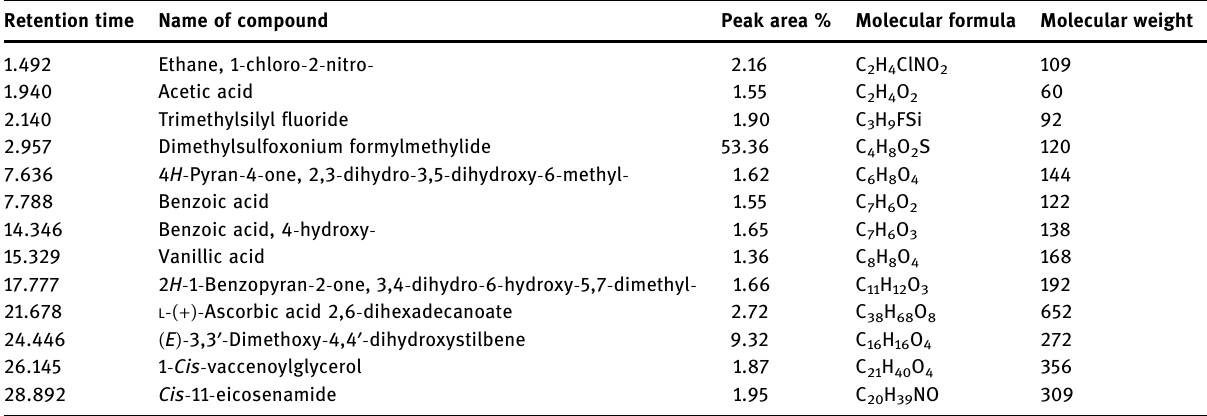
Table 5: Compounds identi fi ed in aqueous extract of P. indica by GCMS Retention time Name of